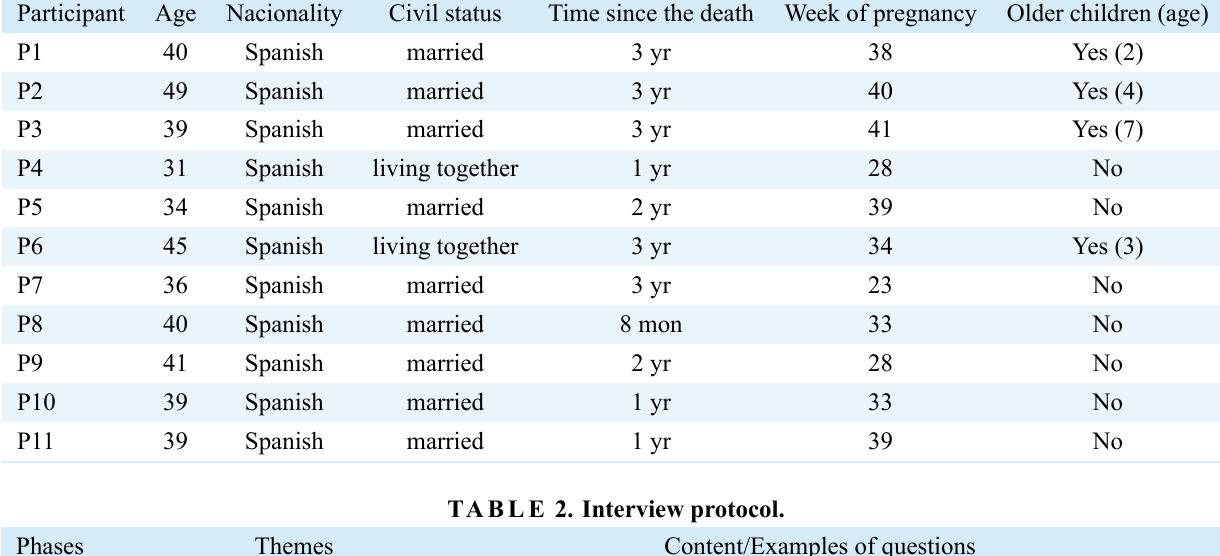
TABLE 1. Sociodemographic data of the